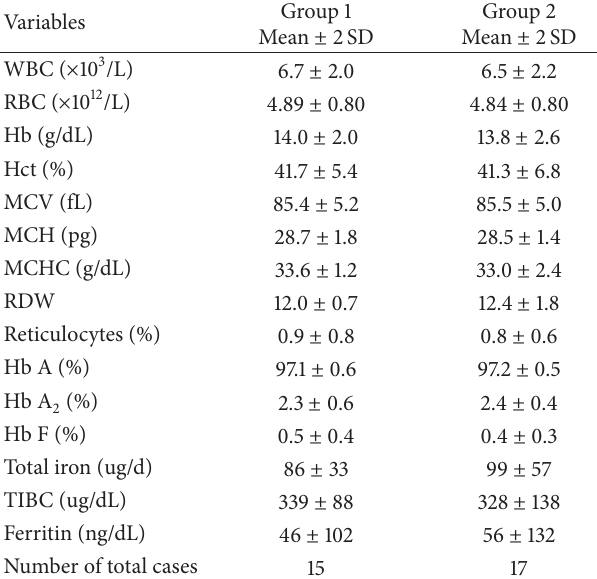
Table 3: Hematological and biochemical